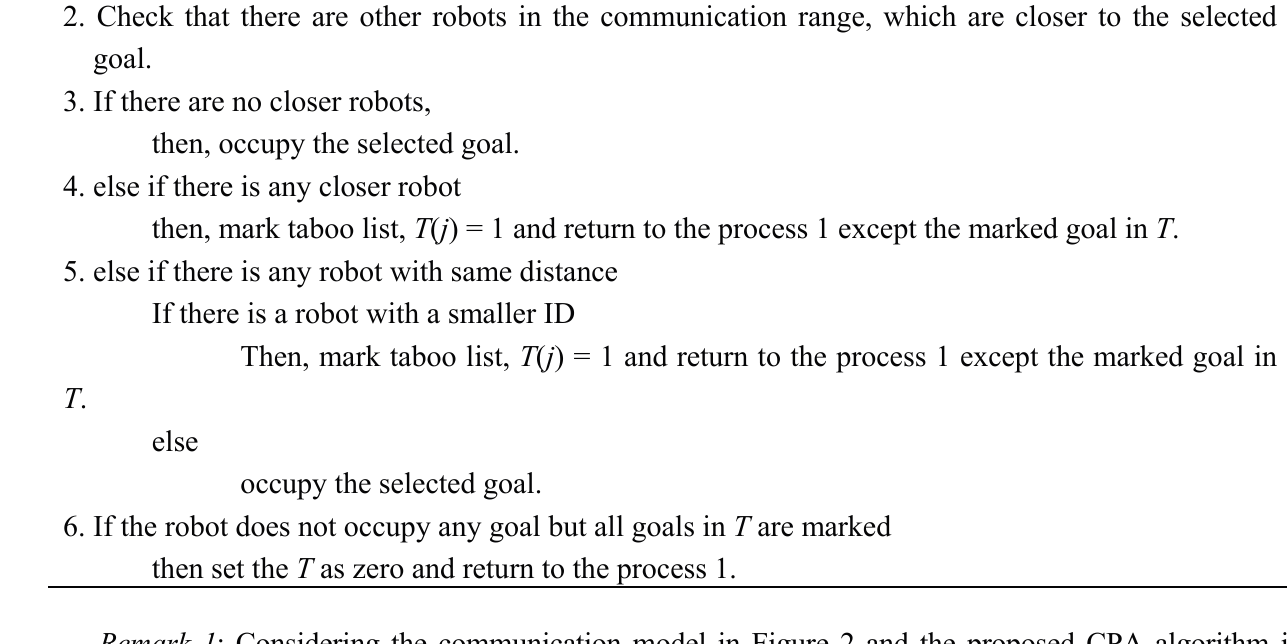
Algorithm 1 The competition of the followers for their